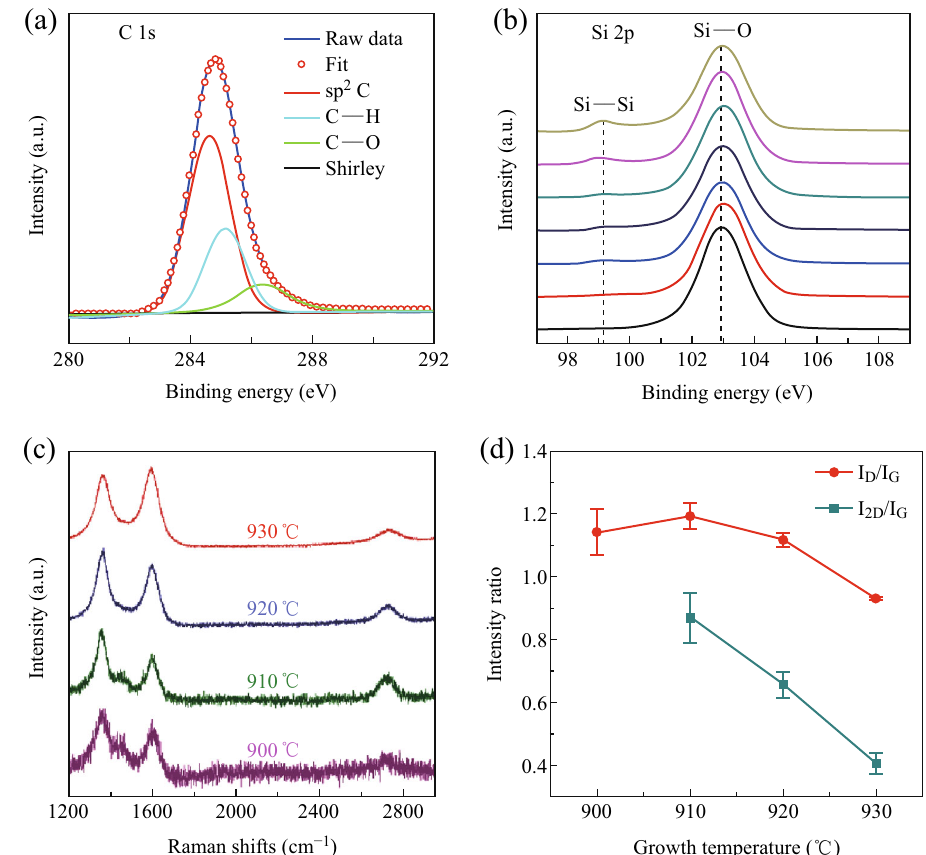
Fig. 4 Spectroscopic characteristics of graphene grown directly on silicon. a C 1 s XPS spectrum of as-grown graphene. b Si 2p XPS spectra of graphene at various growth temperatures, from bottom to top are 900, 905, 910, 915, 920, 925, and 930 (cid:3) C, respectively. c Representative Raman spectra of graphene at various growth temperatures. d Ratio of the Raman D band intensity to that of the G band ( I D / I G ), red, and the 2D band intensity to the G band ( I 2D / I G ), light blue, as a function of growth